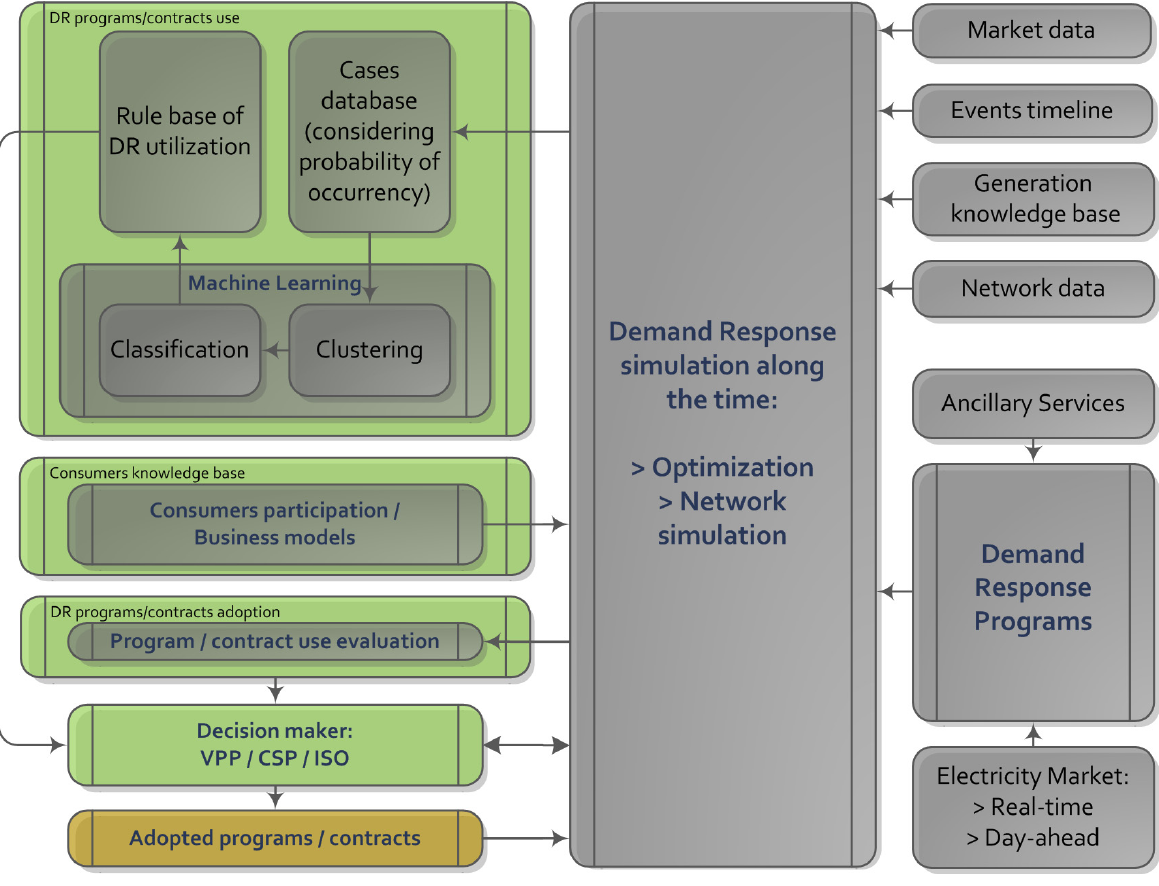
Figure 1. Decision support